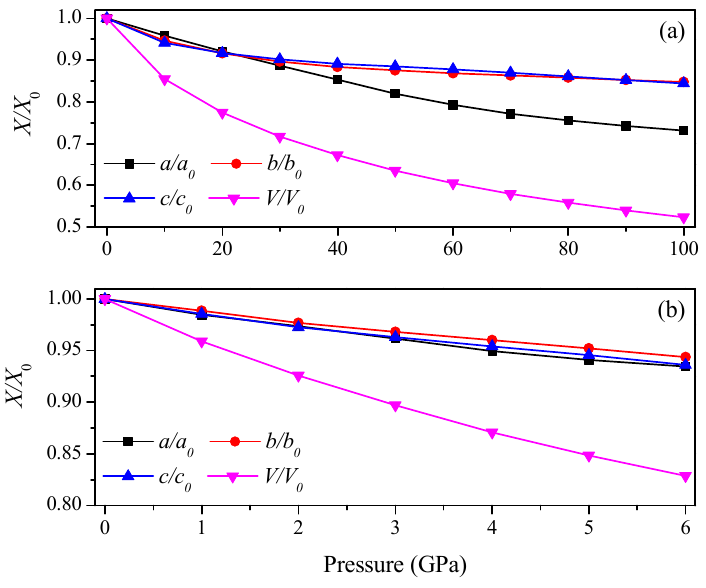
Figure 3. Lattice parameters X / X 0 as a function of pressure. ( a ) Pnma -Ca 2 C; ( b ) C 2/ m -Ca 2 C. The calculated elastic constants and moduli of Ca 2 C at 0 GPa and high pressures are shown in Table 3. The strain-stress method was used to calculate the single crystal elastic constants. A small finite strain was applied on the optimized structure and the atomic position was fully optimized. Then, the elastic constants were obtained from the stress of the strained structure. The generalized Born’s mechanical stability criteria of orthorhombic phase at 0 GPa are given by [17,18]: C ii ą 0, i “ 1 . . .